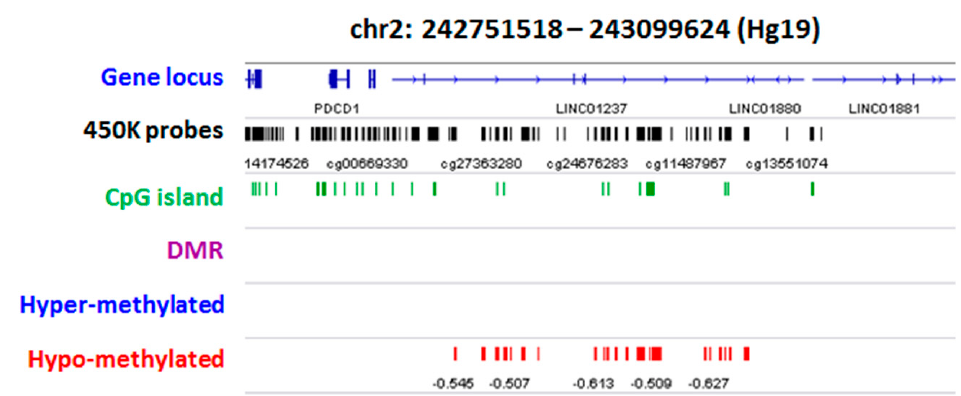
Figure 4. IGV screenshot of the alignment to the genome of the deregulated CpGs of patient OAVS08. The first track shows the map of RefSeq genes. 450K probes and relative CpG Islands are reported in the second and third track, respectively. Hypo-methylated sites are shown in red color.